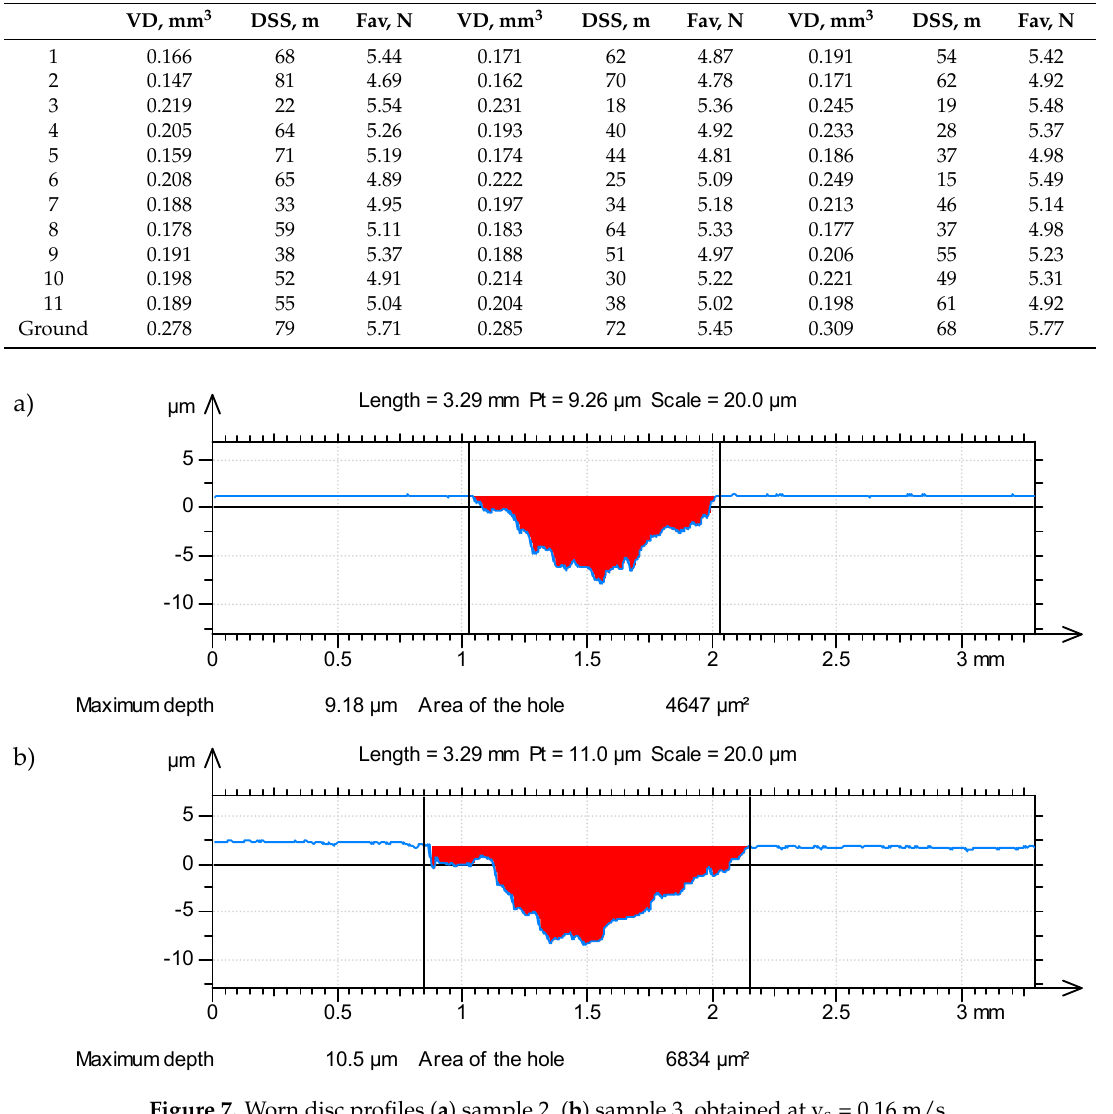
Figure 7. Worn disc profiles ( a ) sample 2, ( b ) sample 3, obtained at v s = 0.16 m/s.